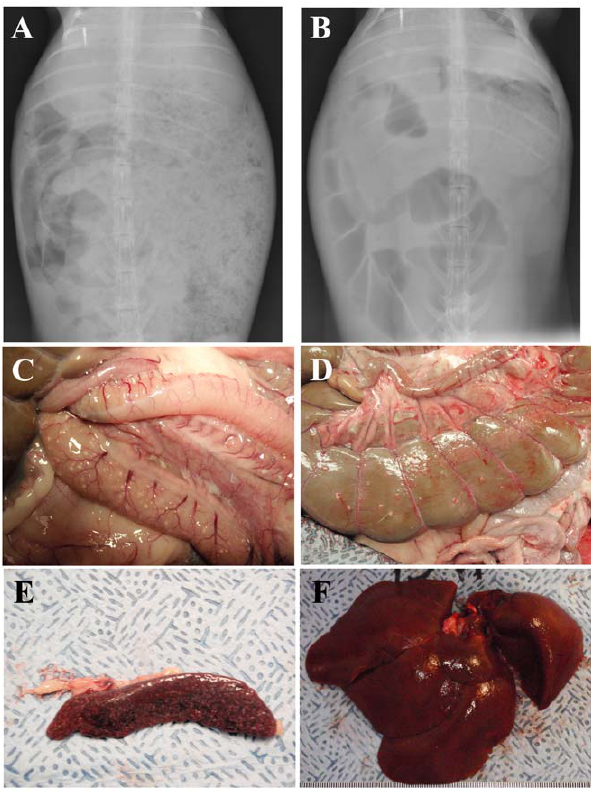
Figure 6. Gastrointestinal pathology and hepatosplenomegaly associated with tularemia in rabbits. Anterioposterior radiographs showing the abdomen of a single representative rabbit two days prior ( A ) and four days after ( B ) infection with F. tularensis, illustrating gas production and distension of the intestines and stomach. Pictures of the small intestines ( C ), colon ( D ), spleen ( E ) and liver ( F ) examined at necropsy from a single representative rabbit.